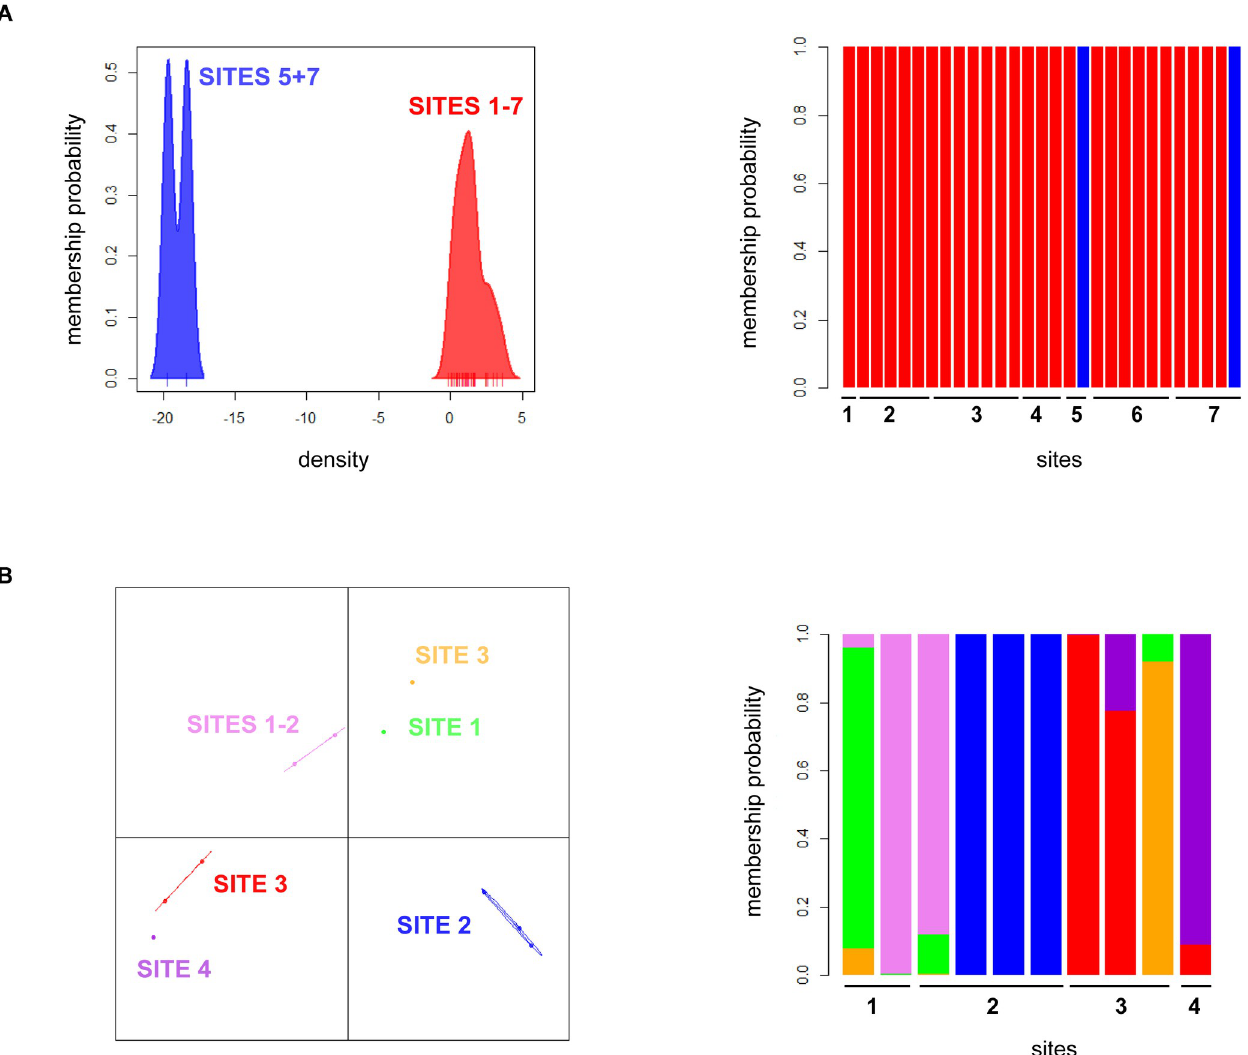
Fig 3. Comparative DAPC analysis for Ae . aegypti samples from Area 2 (A) and Area 3 (B) in Buenos Aires city. On the left, scatter plot with individuals (curve area/dots) assigned to the detected clusters using the k means function find.clusters. On the right, individual membership probability to each cluster (vertical lines) using compoplot in Adegenet. Clustering analyses for samples from Area 1 yielded only one cluster and therefore were not included in DAPC